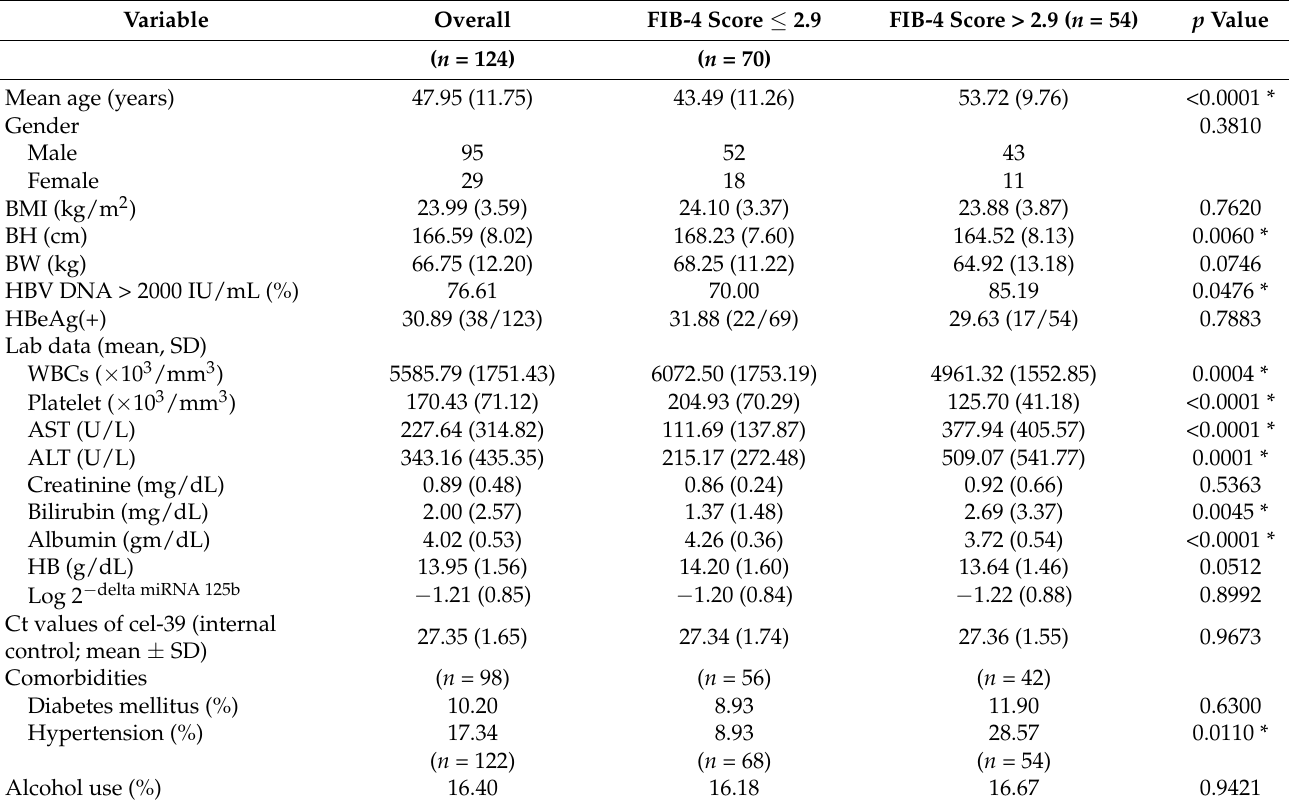
Table 1. Patient’s